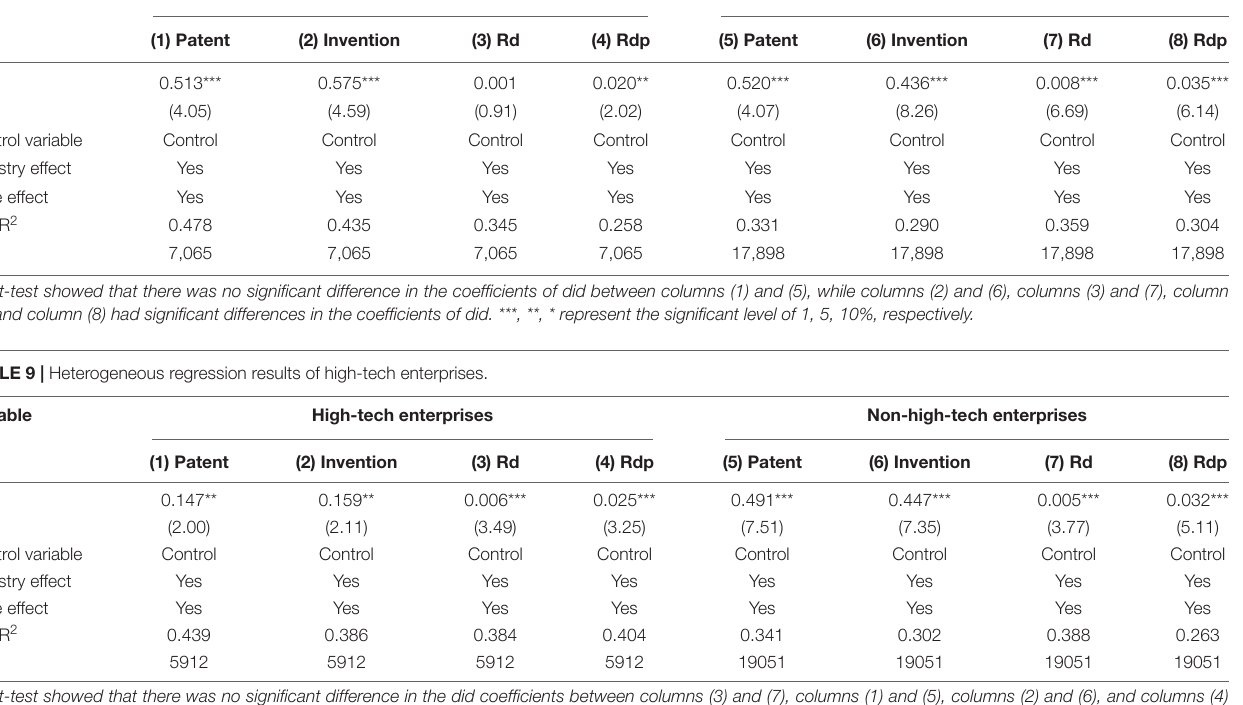
TABLE 8 | Heterogeneous regression results of enterprise ownership. Variable SOEs